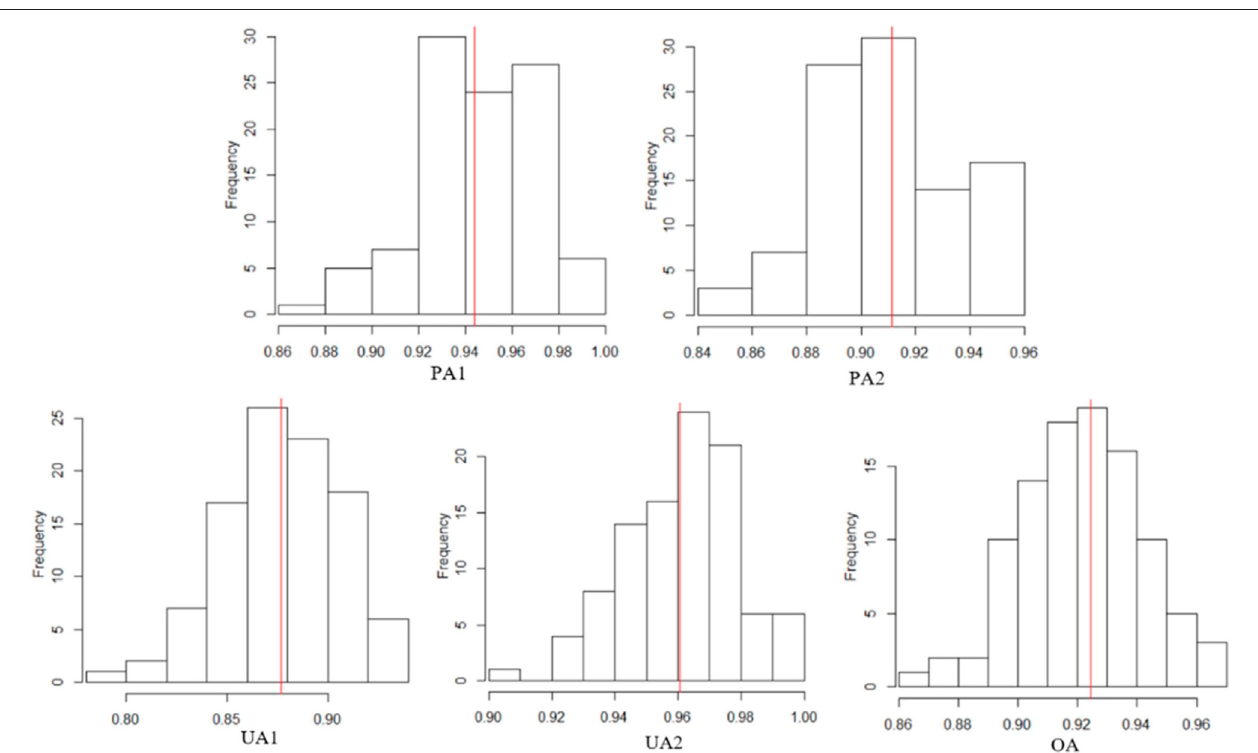
FIGURE 5 | Histograms of different training sample accuracies based on 100 sets of training samples. The red vertical lines mark the classi fi er global accuracies.